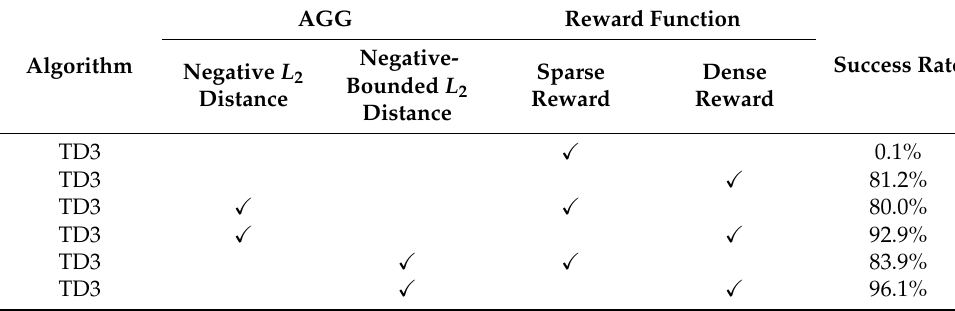
Table 3. Success rates of TD3 and different variants of TD3 +